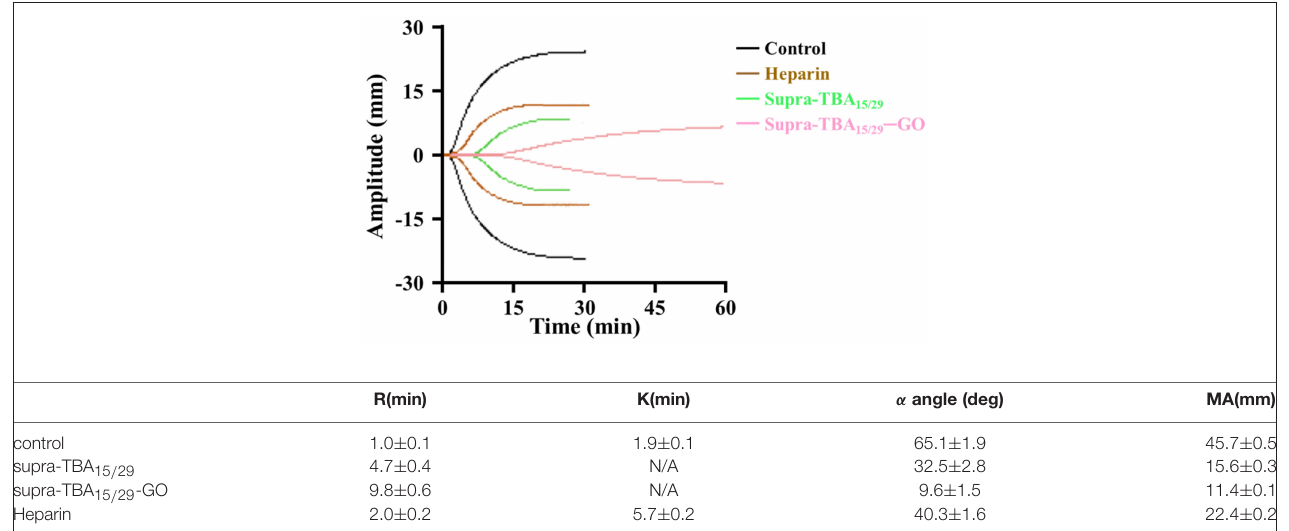
FIGURE 4 | Thromboelastography (TEG) of human whole blood treated with PBS control, heparin (100 nM), Supra-TBA15/29 (100 nM), and Supra-TBA15/29-GO (100 nM in term of TBA). N/A, not available.